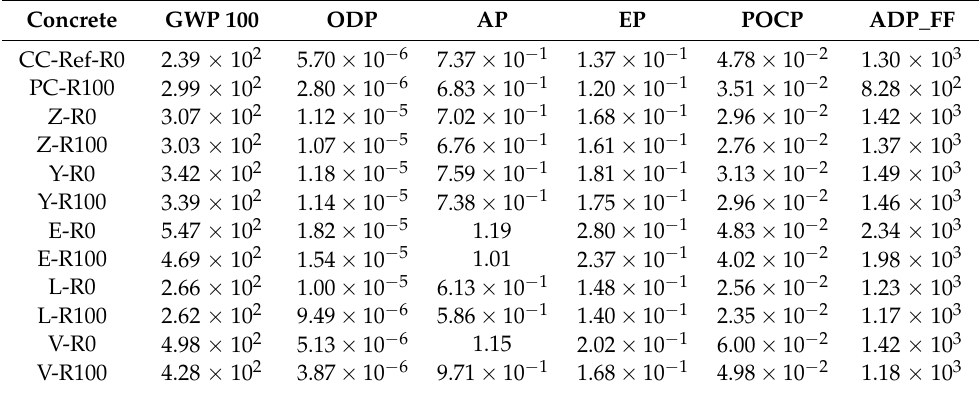
Table 13. Values obtained for the different environmental impact indicators for each concrete formulation in scenario 2.